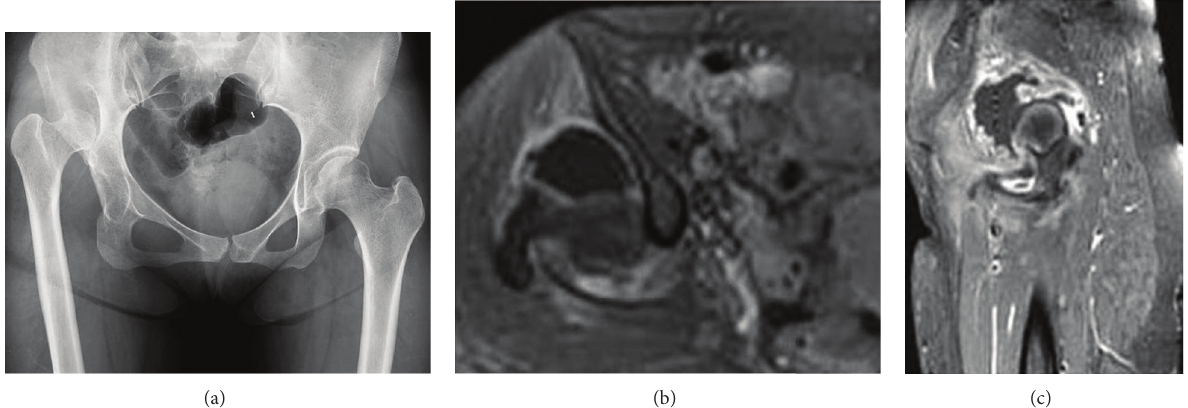
Figure 1: (a) Preoperative hip anteroposterior radiograph of a 28-year-old woman shows right hip high dislocation, a small femoral canal, and a pseudoacetabular joint. (b) and (c) Preoperative axial and sagittal T2 weighted enhanced MR images of the right hip joint show an inflammatory reaction with huge joint effusion and synovial